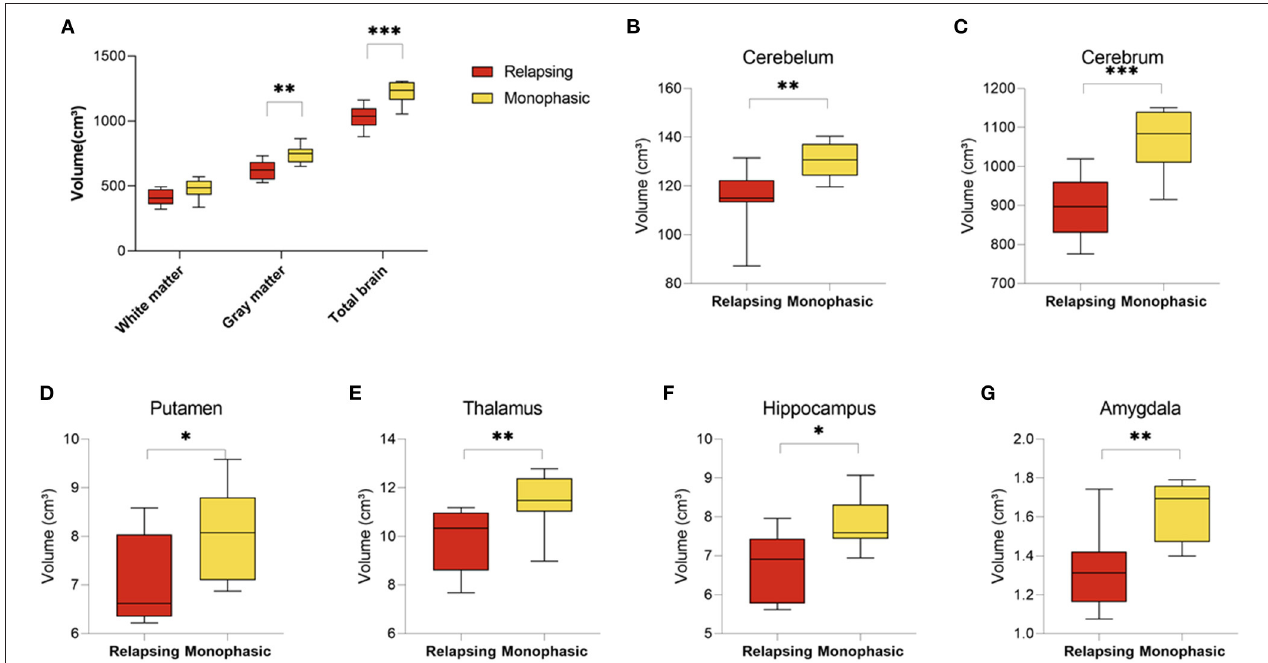
FIGURE 3 | Decreased brain volume in relapsing compared to monophasic MOGAD patients. Brain volume of relapsing ( n = 8) and monophasic MOGAD patients ( n = 8) analyzed by Volbrain software. (A) White matter (413.63 ± 62.74 vs. 476.17 ± 74.35, p = 0.088), gray matter (620.94 ± 73.22 vs. 747.28 ± 68.61, p = 0.003) and whole brain volumes (1,034.07 ± 88.93 vs. 1,223.45 ± 86.84, p < 0.001), (B) cerebellum (114.95 ± 12.81 vs. 130.48 ± 7.08, p = 0.010), (C) cerebrum (899.04 ± 88.93 vs. 1,070.78 ± 86.84, p < 0.001), (D) Putamen (7.02 ± 0.94 vs. 8.04 ± 0.96, p = 0.051), (E) thalamus (9.88 ± 1.30 vs. 11.45 ± 1.19, p = 0.024), (F)